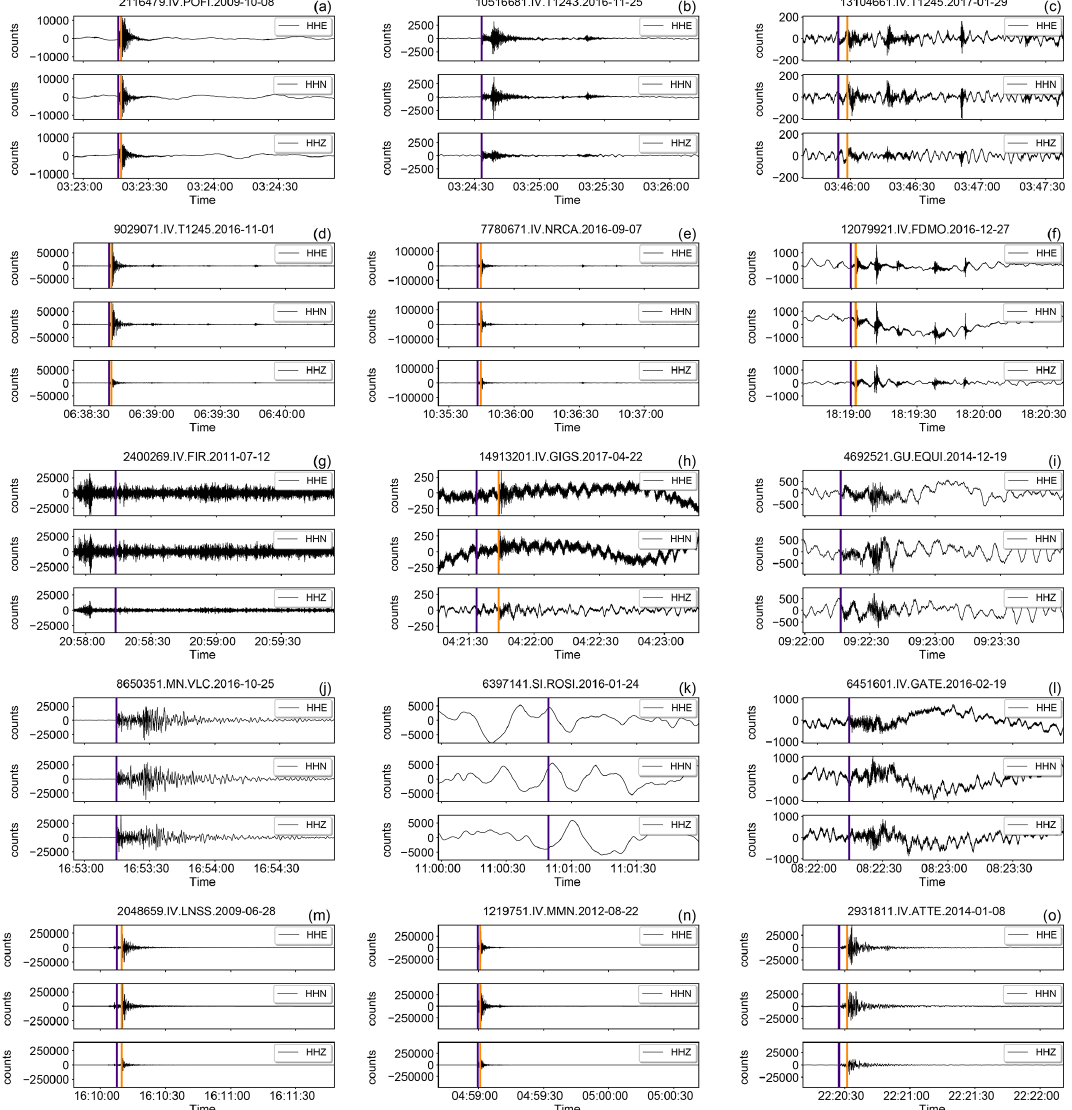
Figure 15. Example of randomly selected “problematic” earthquake waveforms of the broadband HH channels. Each row contains three, randomly selected, 3C traces drawn according to the following criteria based on the metadata listed in Table 2: (a–c) traces with trace_GPD_[P,S]_number > 3 (7.96% of the total of the HH channels); (d–f) traces with trace_EQT_number_detections > 3 (0.38% of the total of the HH channels); (g–i) traces trace_[ENZ]_snr_db with at least one component in the 10% quantile (18.10% of the total of the HH channels); (j–l) traces with all trace_[ENZ]_median_counts either in the first 10% or the last 10% quantiles (5.90% of the total of the HH channels); (m–o) traces with trace_[ENZ]_median_counts either in the first 10% or the last 10% quantiles and corresponding trace_[ENZ]_snr_db excluded from the first quartile (5.06% HH dataset). The arrival times of